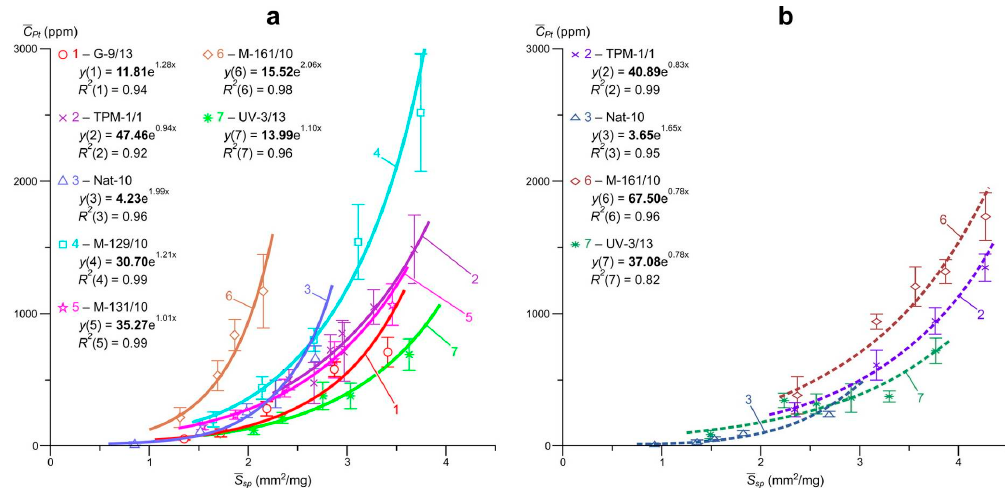
Figure 5. Dependences of the average content of evenly distributed platinum on the specific surface area of an average crystal in size fractions of arsenopyrite ( a ) and pyrite ( b ) from vein, streaky-vein and veinlet-disseminated ores of the Natalkinskoe deposit. The expressions for approximate curves are shown here and in Figures 6–8, in which the pre-exponential factor (in bold) is an estimate of the content of the structural form of the element. The contents of structurally and surface-bound forms of Pt, Pd, Ru and Rh in arsenopyrite and pyrite are given in Tables 3–6. Points 1–7 here and in Figures 6–8 correspond to the ore samples described in Table 1.